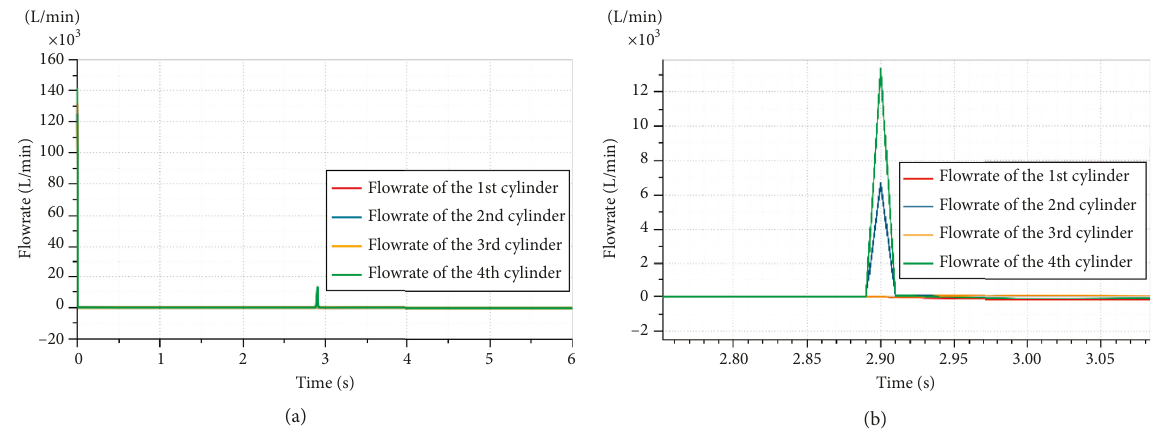
Figure 13: Flow rate curve of the hydraulic cylinder without rod chamber in the connection device.